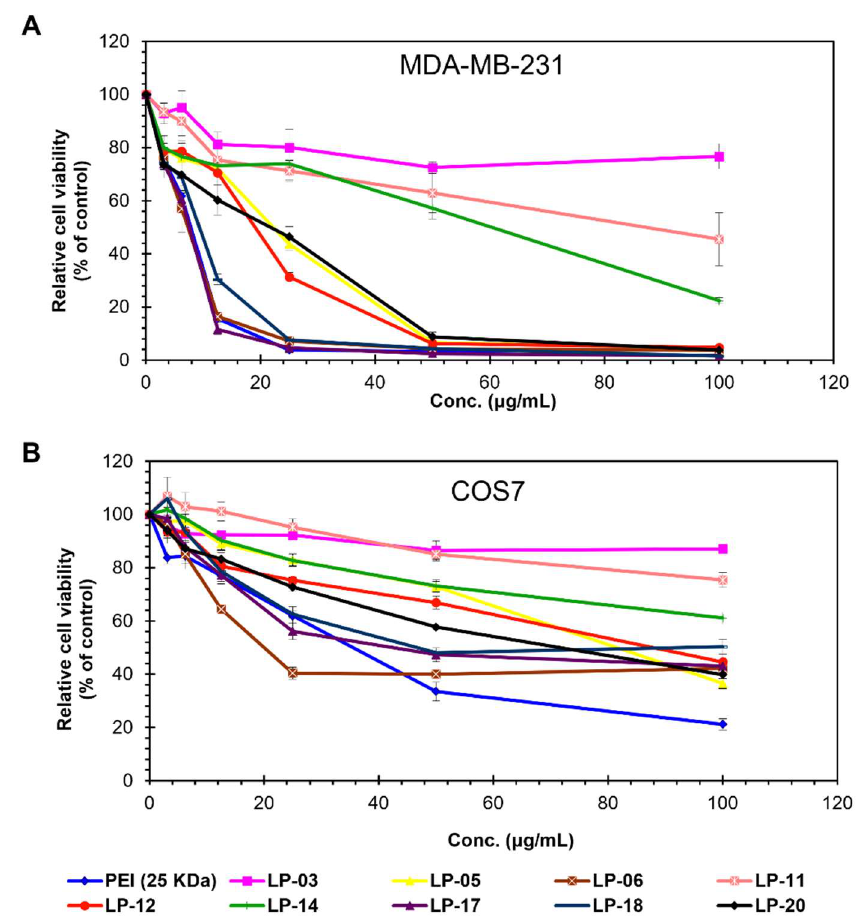
Figure 7. Cell viability assay of lignin-PDMAEMA copolymers in MDA-MB-231 ( A ) and COS7 ( B ) cells in comparison with branched PEI (25 kDa). Data represent mean ± standard deviation ( n = 6). Data for LP-14 was reported previously